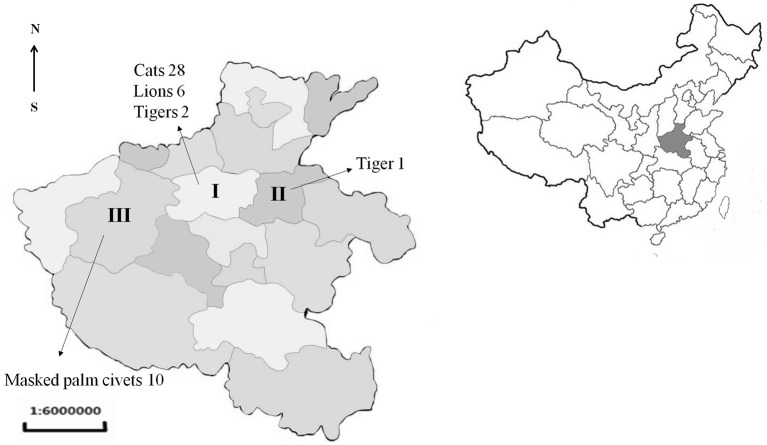
Location and number of samples received from Henan province of China. I, Zhengzhou; II, Kaifeng; III, Luoyang.